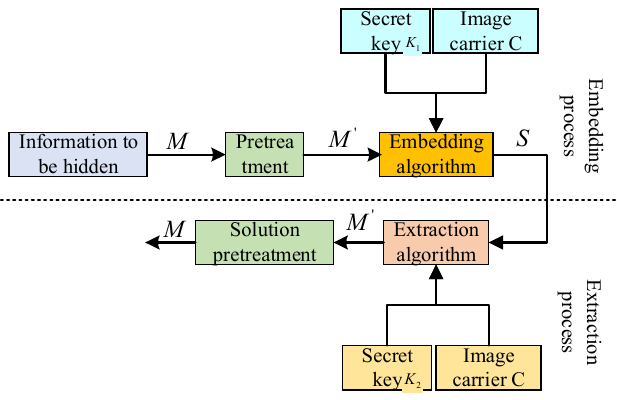
Figure 3. Frame model of image hiding.